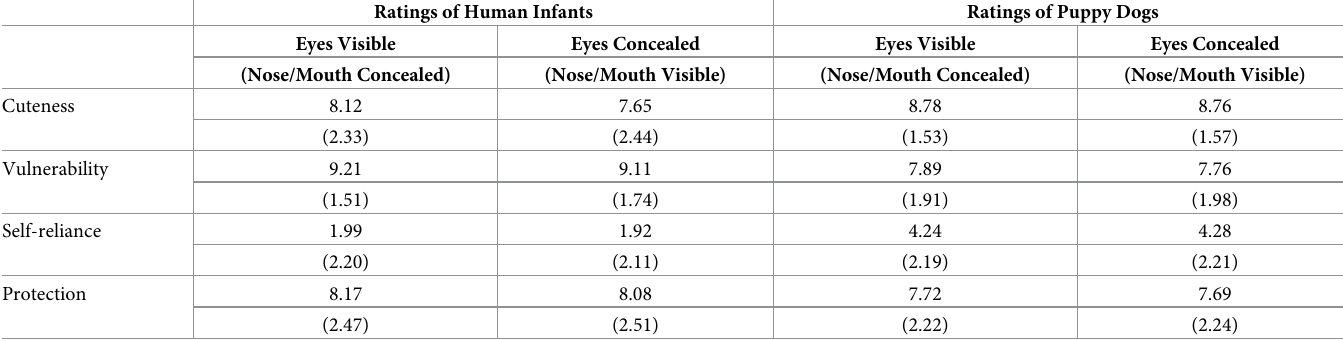
Table 1. Experiment 1: Mean ratings (with standard deviations in parentheses) of human infants and puppy dogs, as a function of whether their eyes were visible or